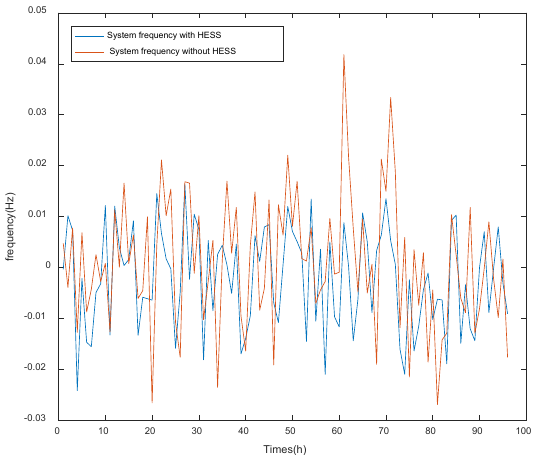
Figure 13. Comparison of frequency response before and after each period.